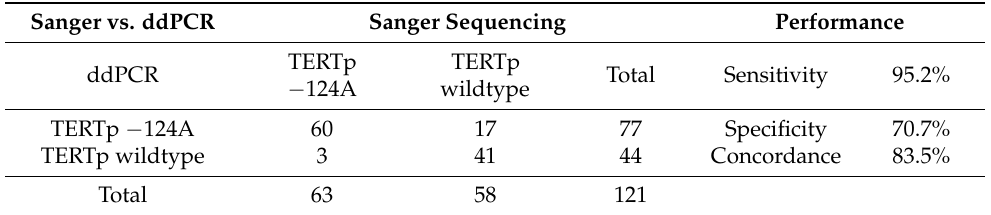
Table 2. Concordance rate between Sanger sequencing and ddPCR assay. Sanger vs. ddPCR